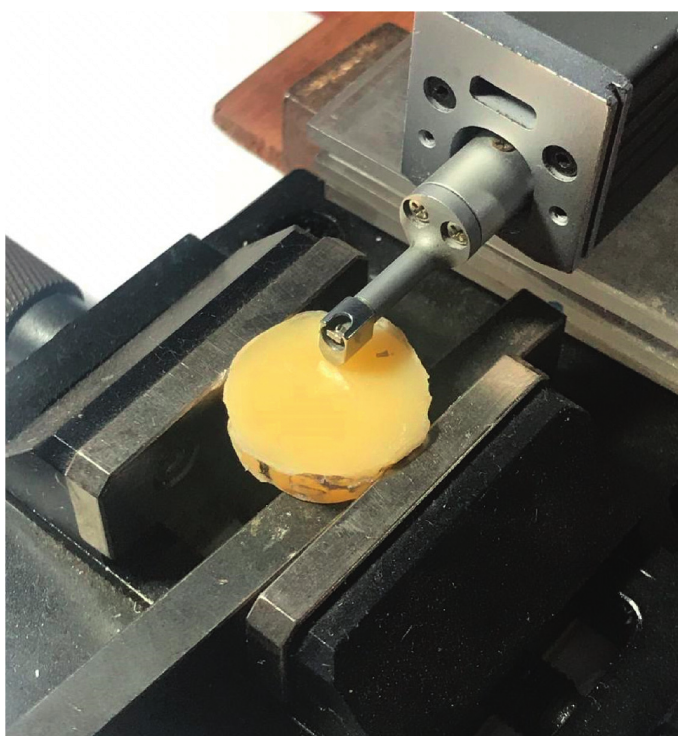
Figure 5: Roughness